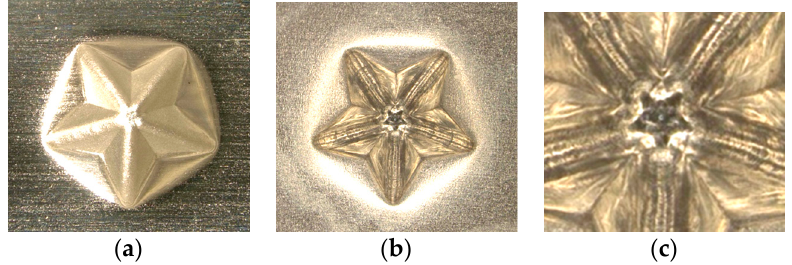
Figure 9. Top and bottom views of a star pyramid formed with ultrasonic vibration: ( a ) top view; ( b ) bottom view; ( c ) magnified center part of bottom view.